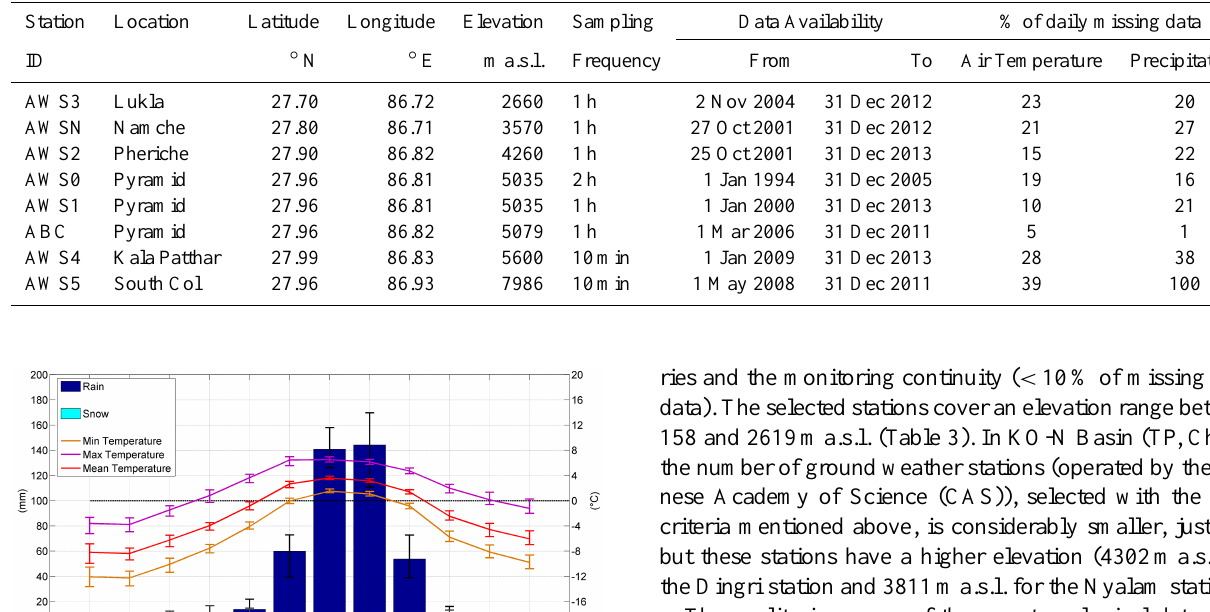
Table 1. List of surface stations belonging to PYRAMID Observatory Laboratory network located along the south slopes of Mt. Everest (upper DK Basin).